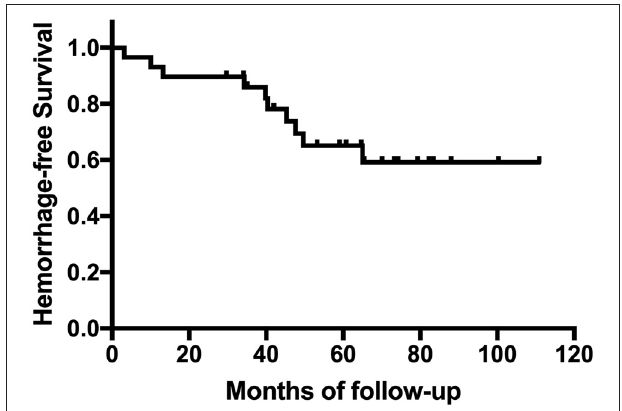
FIGURE 2 | Kaplan–Meier curve for cumulative rates of hemorrhage for patients with hemorrhagic transformation (HT).